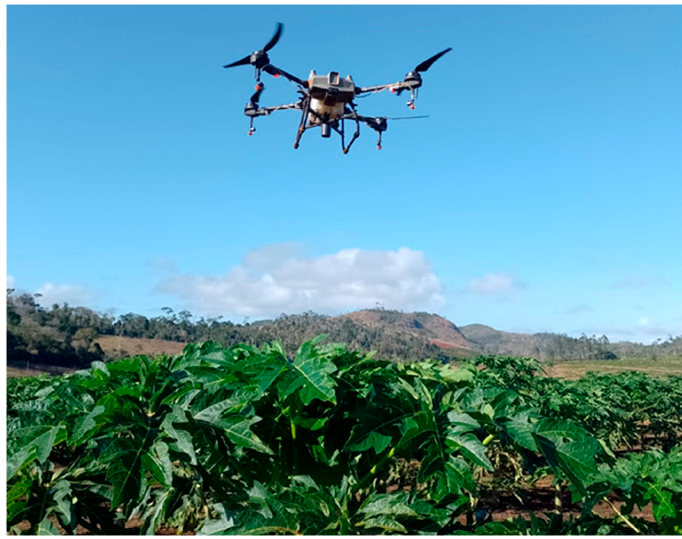
Figure 2. Multi-rotor unmanned aerial vehicle used in the spraying experiment.